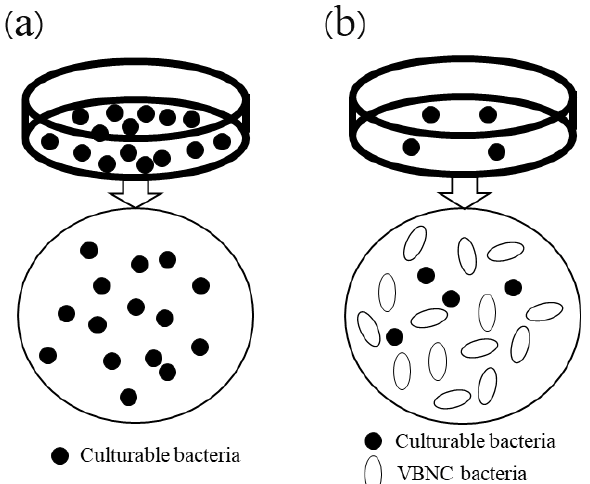
Figure 1. Schematic diagram of culturable bacteria ( a ) and VBNC bacteria ( b ).